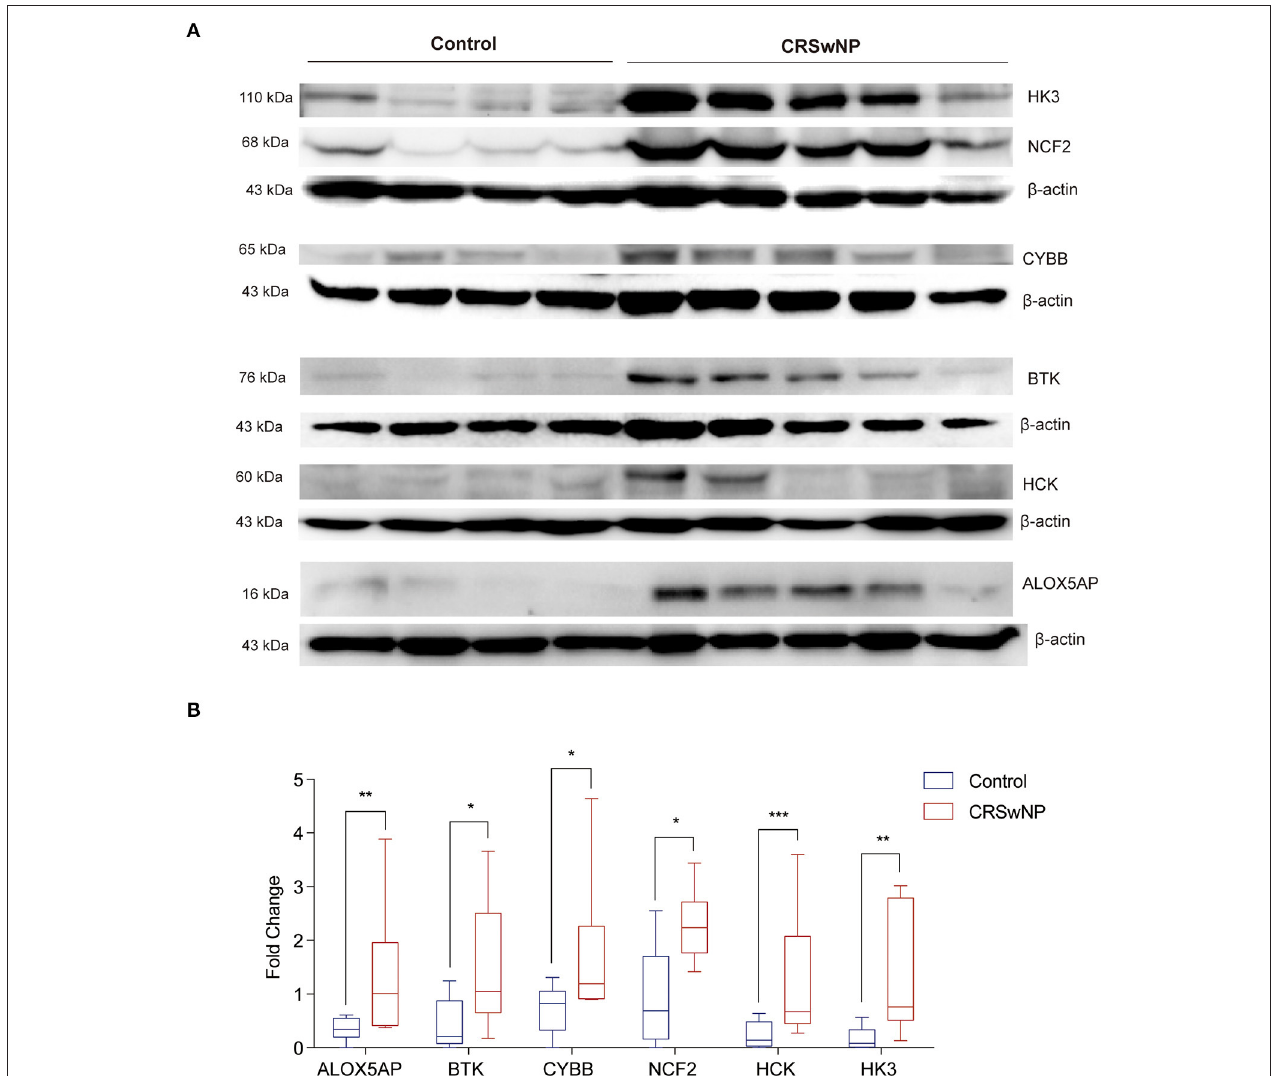
FIGURE 5 | The protein expression levels 6 hub genes were significantly increased in CRSwNP by western blot analysis. (A) The expression level of ALOX5AP, BCL2A1, BTK, CYBB, NCF2, HCK, and HK3 proteins in nasal polyps from CRSwNP patients ( n = 10) and nasal mucosal tissues from healthy control ( n = 8). (B) Fold changes of relative expression ratio of ALOX5AP, BCL2A1, BTK, CYBB, NCF2, HCK, and HK3 compare to β -actin in CRSwNP and healthy controls. The expression level of β -actin was used as a reference. * P < 0.05, ** P < 0.01, *** P <